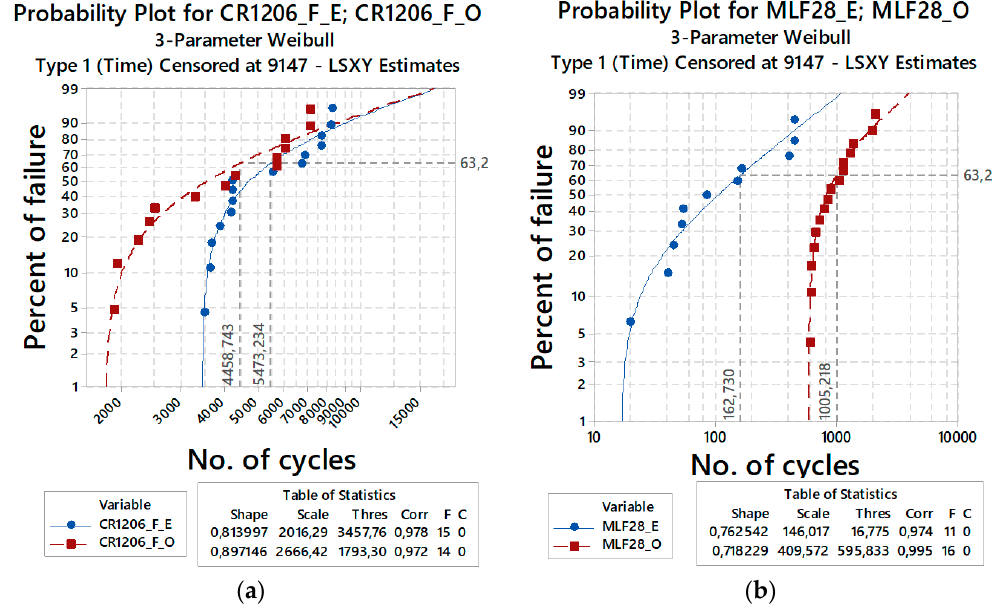
Figure 12. Probability plots according to the least squares’ estimation method and right censored data at 9147 cycles, showing the combinations with the maximum differences in lifetime. ( a ) The maximum gain in case of CR1206_F and ( b ) the maximum reduction in case of MLF28.